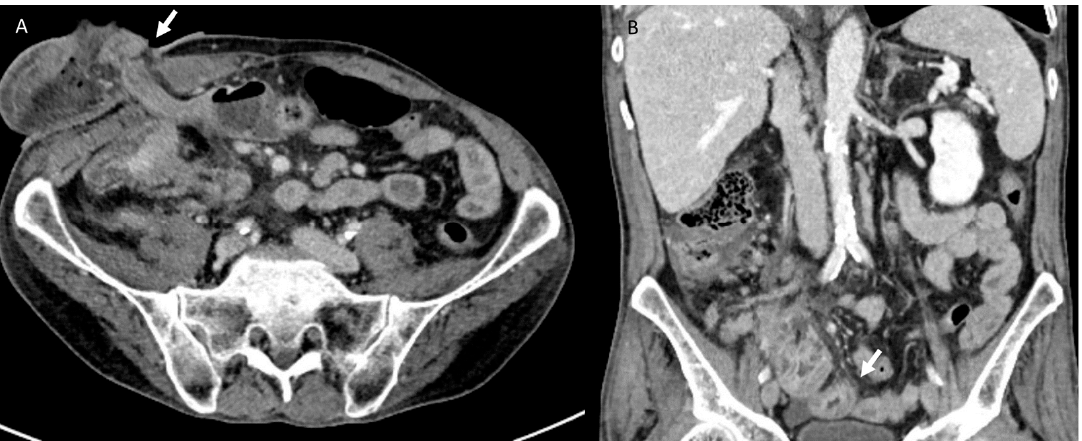
Figure 6. CT assessment of stomal hernia. In ( A ) (axial plane), the arrow shows parastomal fat accumulation at the stoma site. In ( B ) (MPR coronal plane), the arrow shows intestinal wall edema. A protrusion of a viscera through a defect in the peritoneal or retroperitoneal compartments configures the potentially life-threatening condition of internal hernia [73]. Although the reported rates only reach 0.65% [74], the main concern is vascular impairment